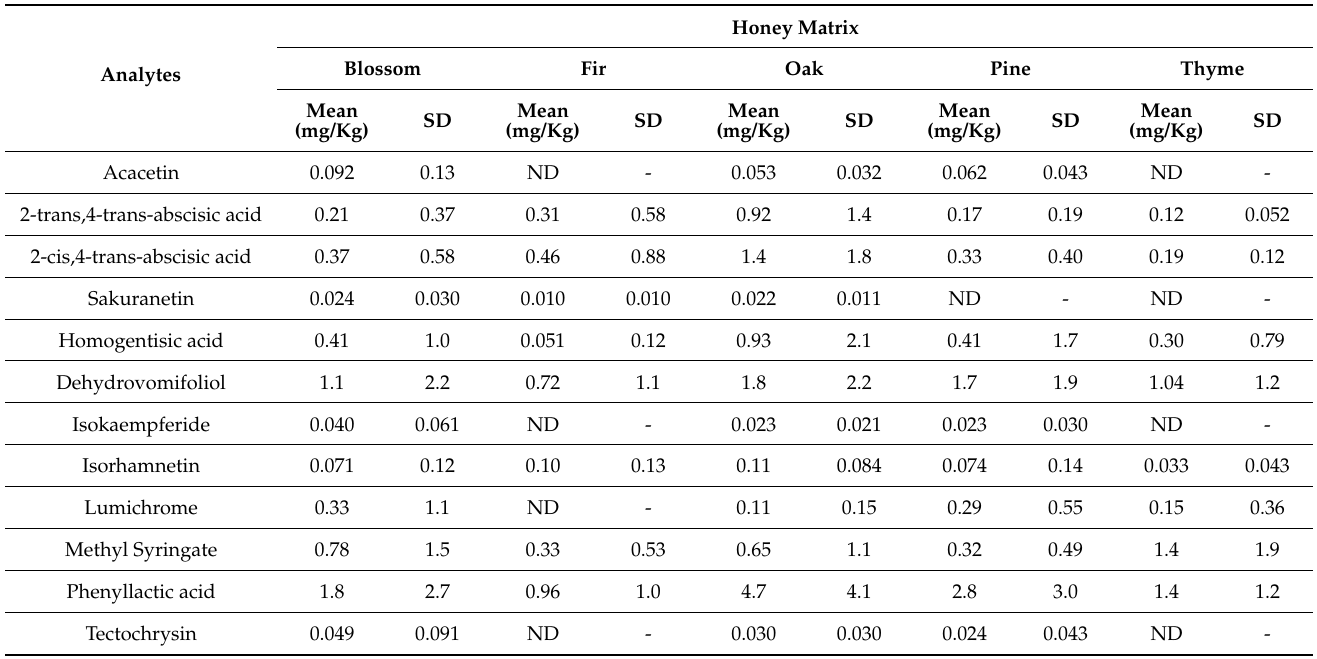
Table 2. Semi-quantification of the analytes identified through suspect screening in the 5 different honey